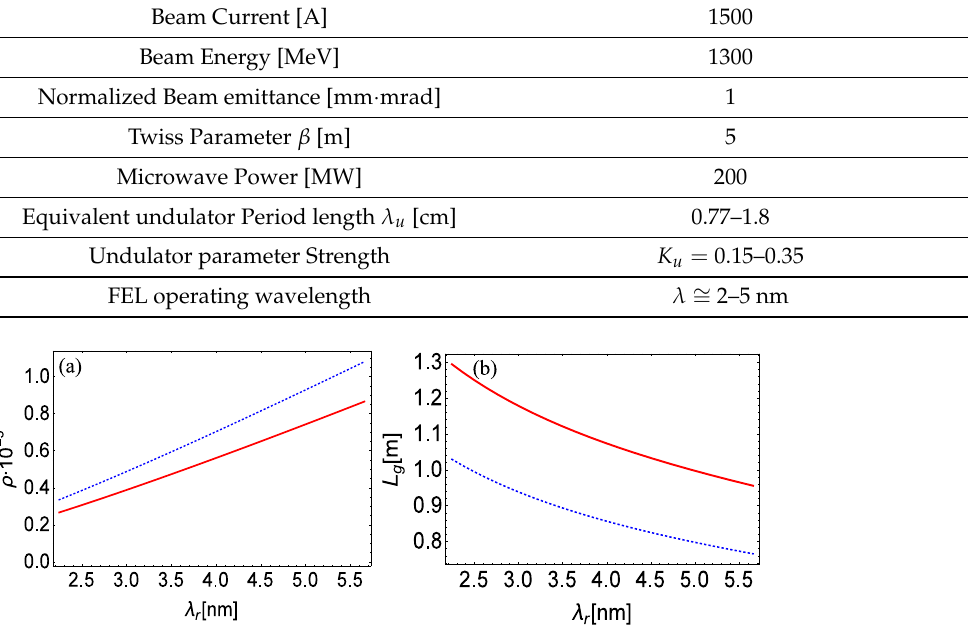
Figure 9. ( a ) Pierce parameter vs. wavelength ( b ) gain-length vs. wavelength P = 200 MW (solid line) P = 400 MW (dotted line).